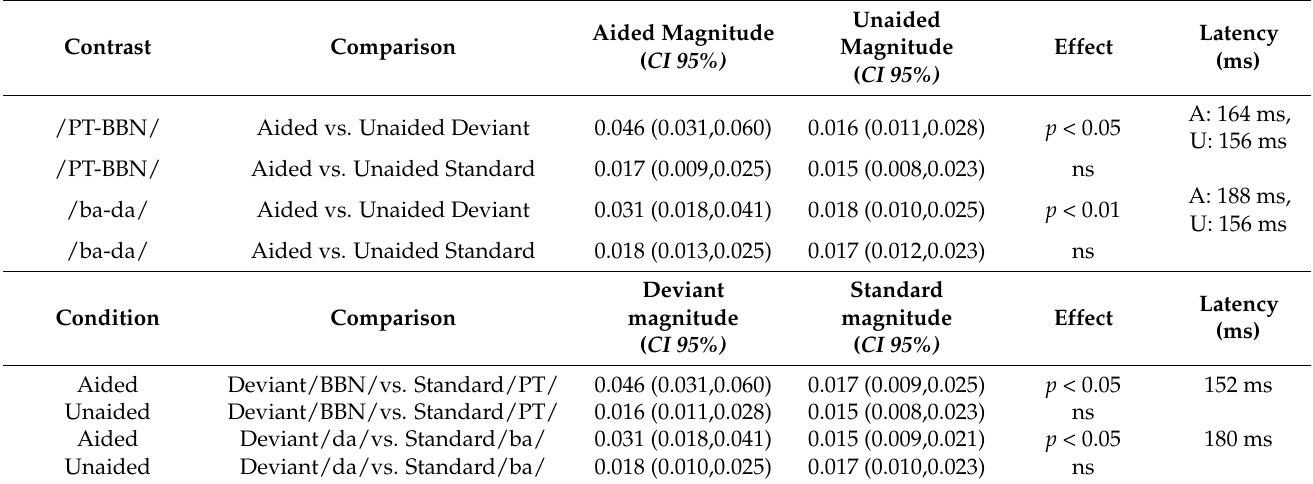
Table 2. Alpha band response